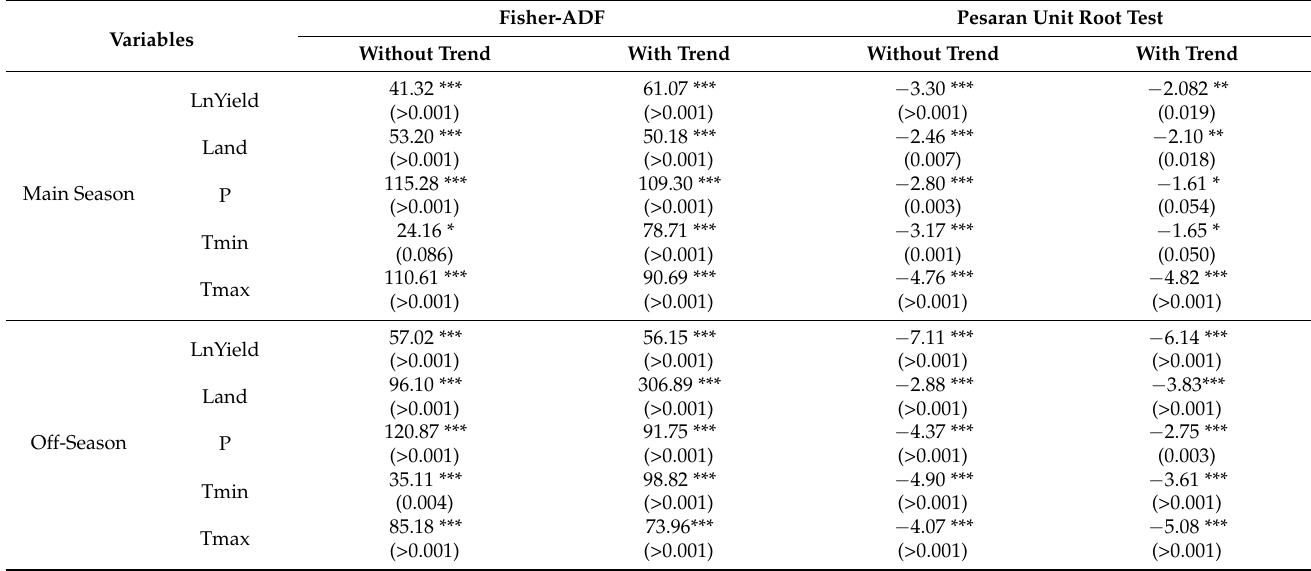
Table 5. Panel unit root test.